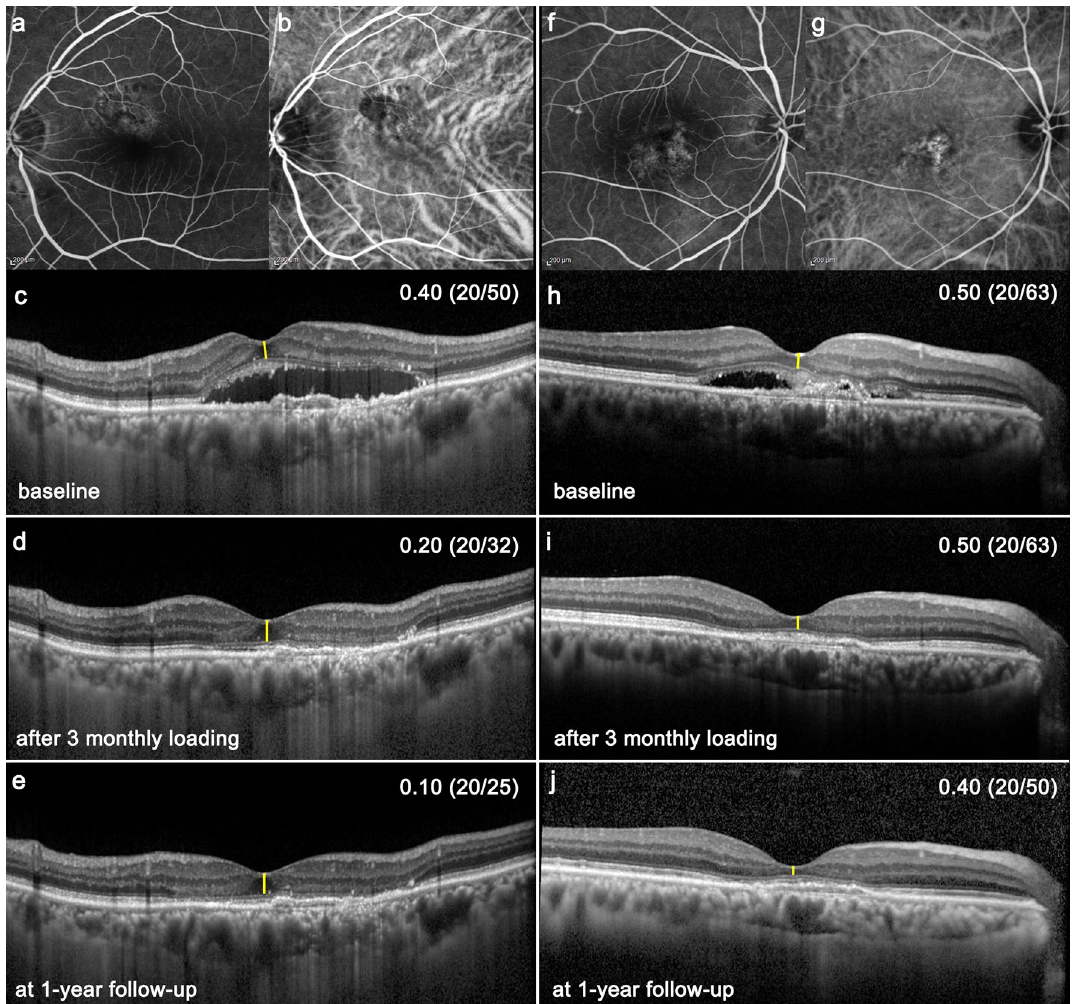
Figure 3. Representative images of the subgroup A and B. The left column images ( a , b , c , d , and e ) represent group B (i.e., good response), while the right column images ( f , g , h , i , and j ) represent group A (i.e., poor response). Best-corrected visual acuity (BCVA), using the log of minimum angle of resolution and Snellen (parenthesis), is documented on the right upper corner of each image. At baseline, type 1 choroidal neovascularization ( CNV) is diagnosed with fluorescein angiography ( a and f ), indocyanine green angiography ( b and g ), and optical coherence tomography ( c and h ). The group B eye has juxtafoveal CNV while the group A eye has subfoveal CNV. Both eyes have similar ONL thicknesses ( c and h , 59 µm and 45 µm, respectively) and vision at baseline. After 3 initial monthly loading doses with aflibercept, the subretinal fluid is well resorbed in both the groups; however, the ONL thickness and BCVA recovered in the group B eyes ( d , 88 µm), while they remained unchanged in the group A eyes ( i , 45 µm). These differences were maintained until the 1-year follow-up ( e and j , 88 µm, and 40 µm, respectively). The yellow lines indicate the foveal ONL